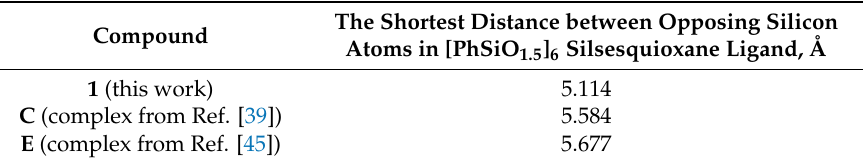
Figure 4. Left : Structure of silsesquioxane ligands in 1 . Center : Molecular structure of Cu 4 -CLMSs from Ref. [45], representing the axial and equatorial locations of sodium centers. Right : The framework of 1 , representing equatorial-only locations of sodium centers. Color code: copper—green, sodium—yellow, oxygen—red, nitrogen—blue. Table 1. Structural comparison of Cu 4 -based CLMSs.